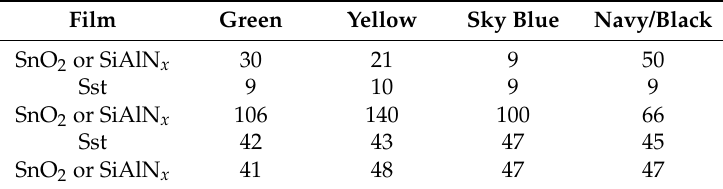
Figure 5. Reflectance of some decorative coatings. Experimental data (points) and simulated data (lines). Table 1. Film thicknesses (in nm) for coatings with different aesthetic